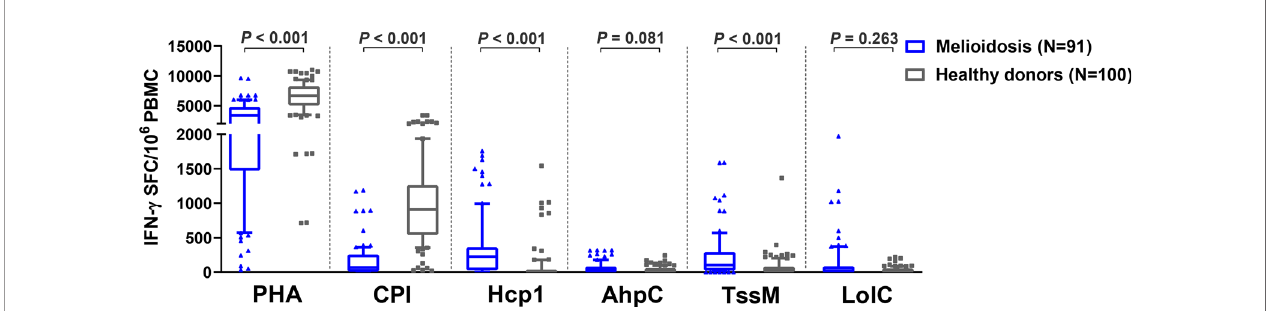
FIGURE 1 | Cellular immune responses to different B pseudomallei vaccine candidate antigens in PBMC from patients during acute melioidosis (day 0) compared to healthy donors. PBMC from 91 melioidosis patients and 100 healthy donors were stimulated with recombinant B pseudomallei proteins (Hcp1, AhpC, TssM, LolC) and controls (PHA and CPI) for 24 hours in vitro and IFN- g secreting cells were measured by ELISpot assays. Data displayed for each antigen is the number of spot forming cells (SFC) per 10 6 PBMC. Box plots represent 25 th and 75 th percentile boundaries in the box with the median line within the box; the whiskers indicate the 10 th and 90 th percentiles. Statistical signi fi cance between groups was determined using the Mann-Whitney test.